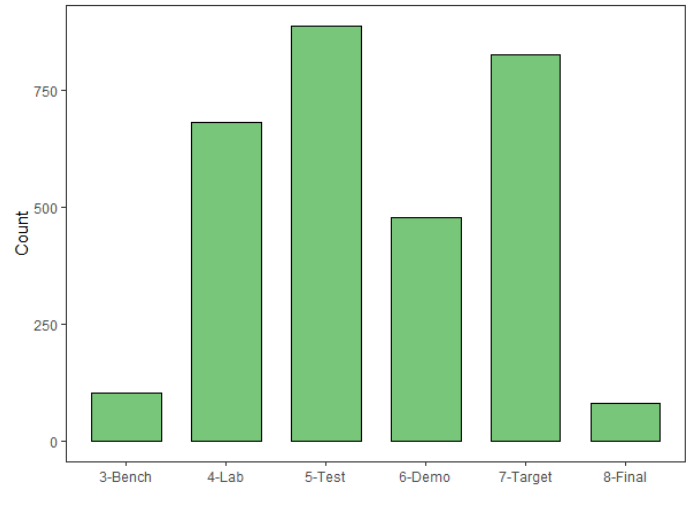
Figure 2. Sensor network deployment distribution by